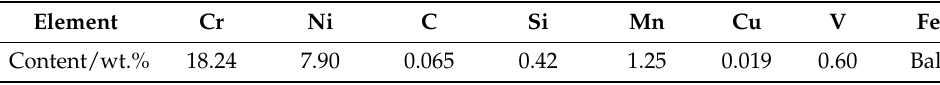
Table 1. Chemical composition of AISI 304 stainless steel.